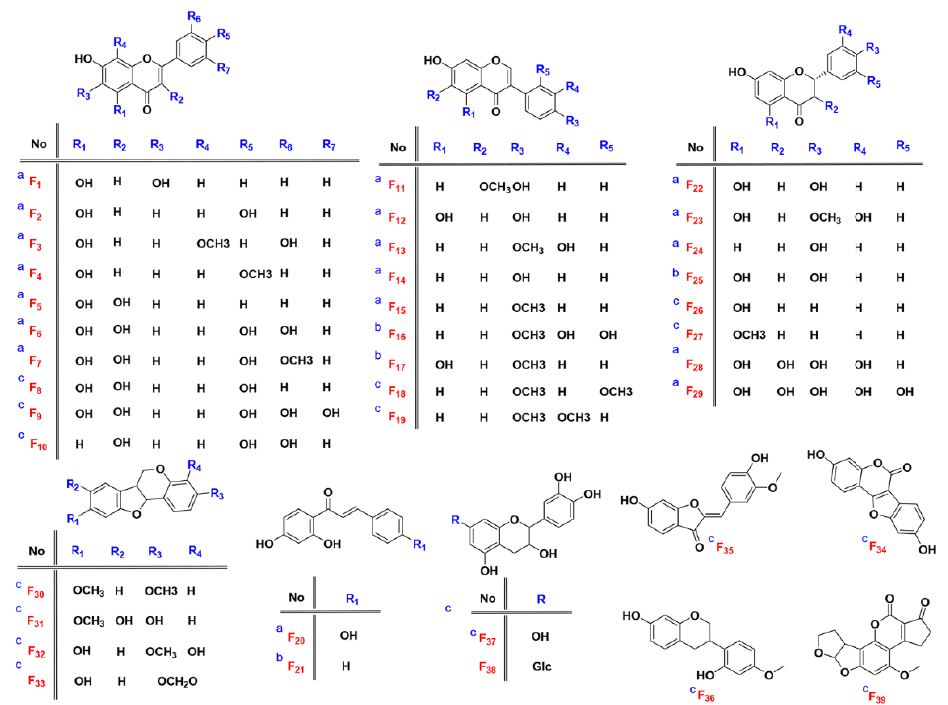
Figure 2. Structures of 39 reference standards and quasi reference standards. ( a ) reference standards; ( b ) quasi reference standards from level 2a; ( c ) quasi reference standards from mzCloud da-